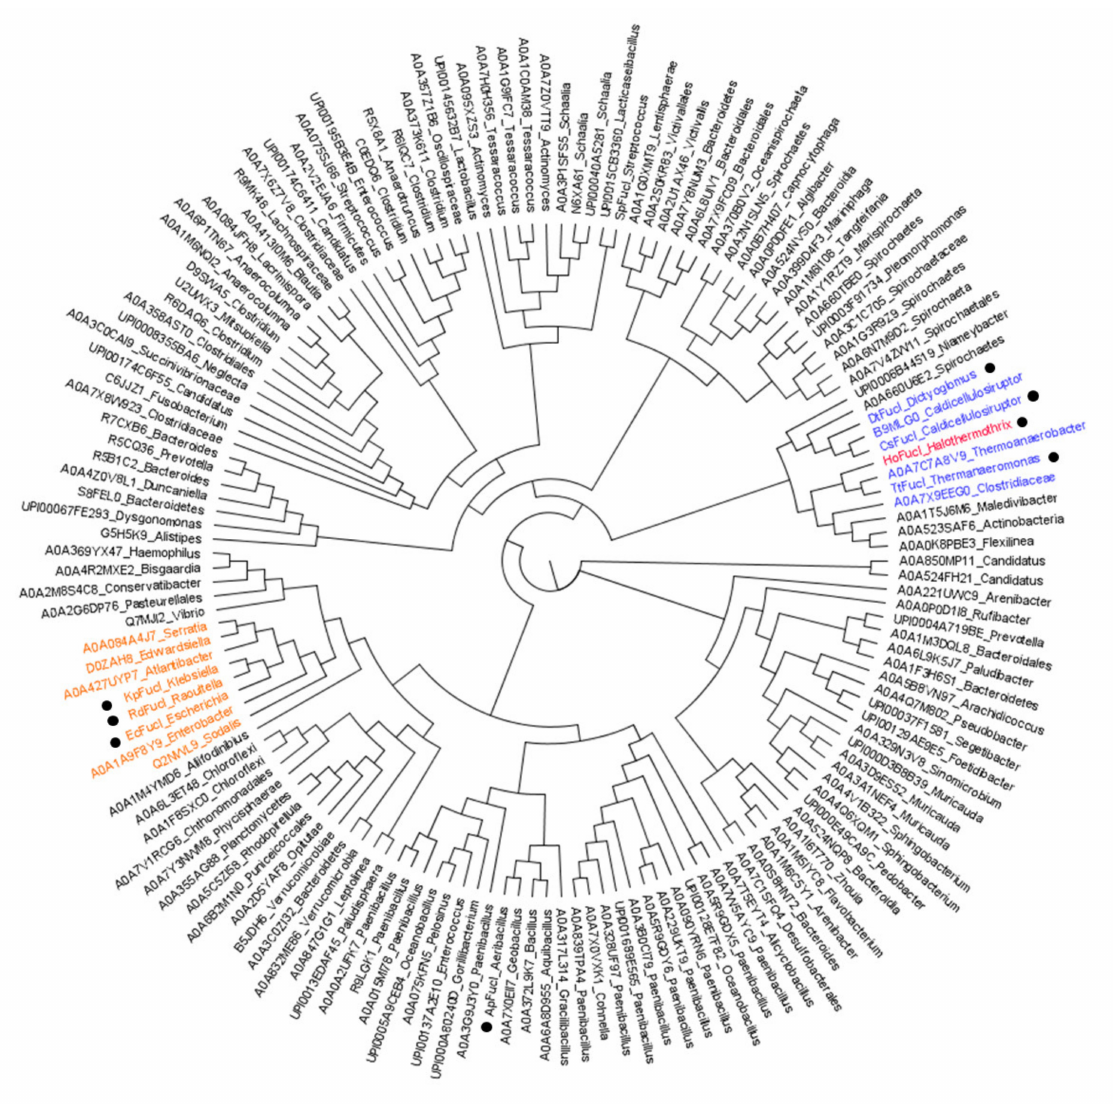
Figure 5. Phylogenetic tree of the L -FucI family. The identities of individual L -FucI protein sequences are indicated by their UniProt accession numbers (https://www.uniprot.org (accessed on 30 March 2022)). The sequences belonging to the Enterobacteriaceae family, clustered together with characterized L -FucI from Escherichia coli ( Ec FucI), L -FucI from Klebsiella pneumoniae ( Kp FucI), and L -FucI from Raoultella sp. ( Rd FucI), are highlighted in orange. The sequences from thermophiles, including L -FucI from Caldicellulosiruptor saccharolyticus ( Cs FucI), L -FucI from Dictyoglomus turgidum ( Dt FucI), L -FucI from Thermanaeromonas toyohensis ( Tt FucI), and Ho FucI, are highlighted in blue. Functionally characterized L -FucI enzymes were labeled with black